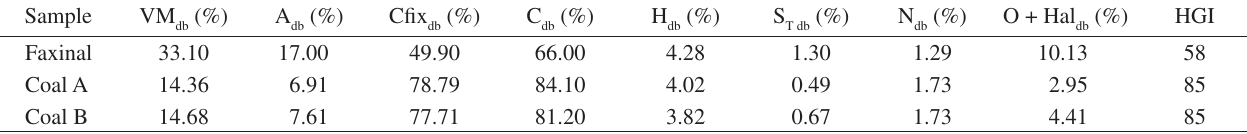
Table 1. Proximate (volatile matter, ashes and fixed carbon) and ultimate analysis (carbon, hydrogen, total sulfur, halogens, nitrogen and oxygen-by differ- ence), in dry basis (db) for Faxinal, A and B coals. Sample